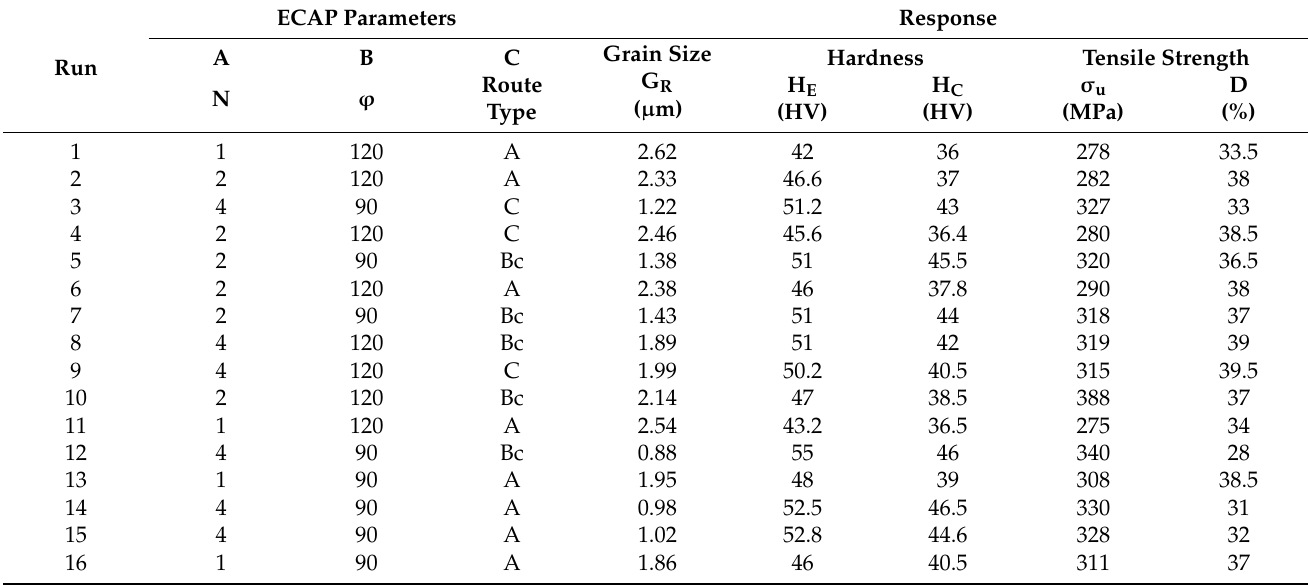
Table A1. Design of experiment of ECAP parameters and their